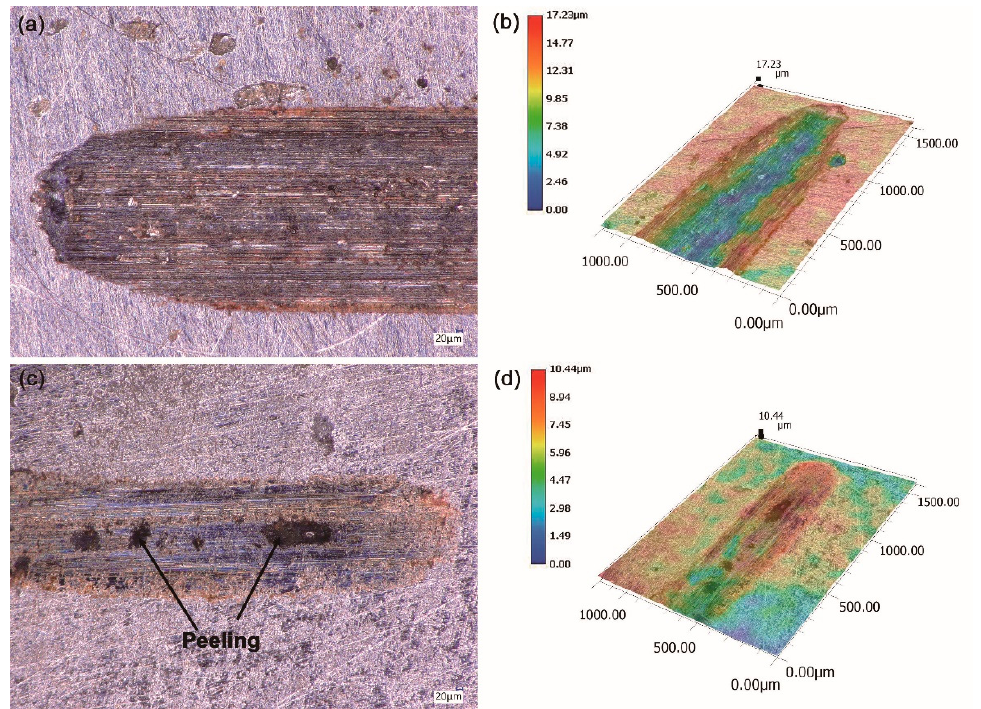
Figure 13. Morphologies of wear tracks of samples: ( a ) and ( b ) NA-2; ( c ) and ( d ) BA-2.